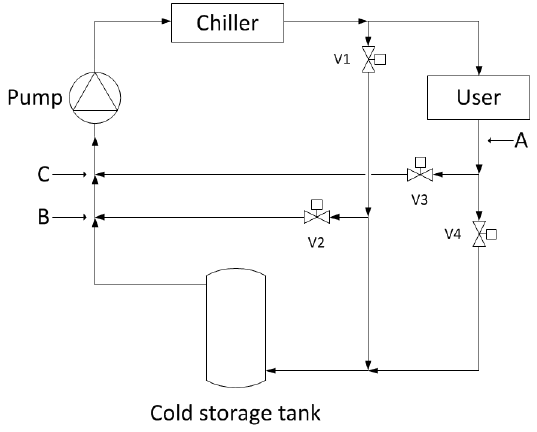
Figure 3. Layout of the refrigeration system.